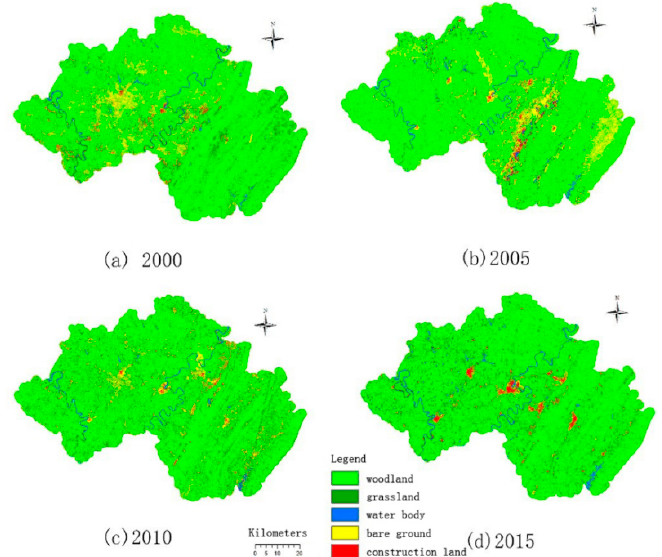
Figure 2. The land classification map of the study area in the four years of 2000, 2005, 2010, and 2015 [13]. ( a ) The land classification map of the study area in 2000 ( b ) The land classification map of the study area in 2005 ( c ) The land classification map of the study area in 2010 ( d ) The land classification map of the study area in 2015 Table 1. The proportion of land-use types in 2000, 2005, 2010, and 2015.